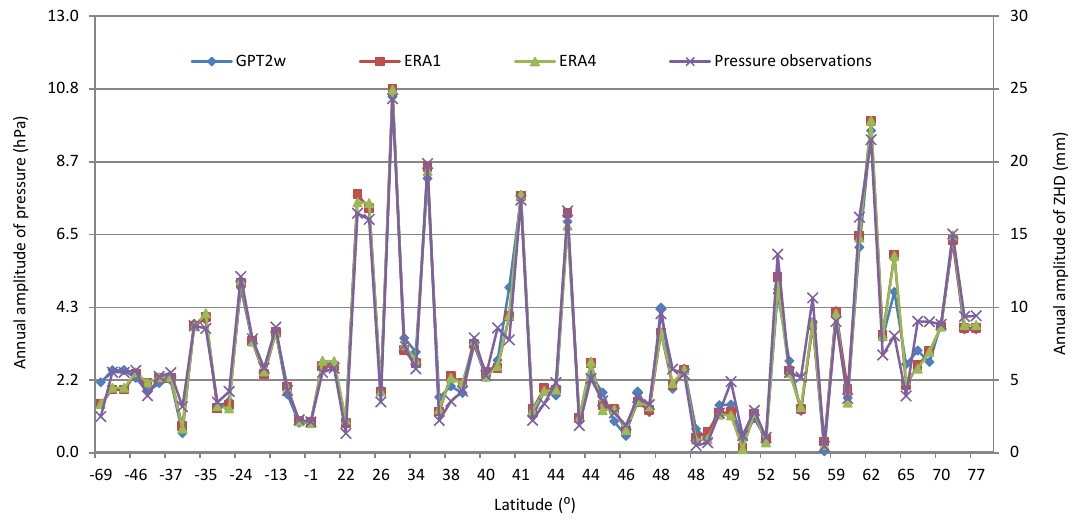
Figure 6. Annual amplitudes of the ZHD derived from P_GPT2w, P_ERA1, P_ERA4 and pressure observations at 76 stations.